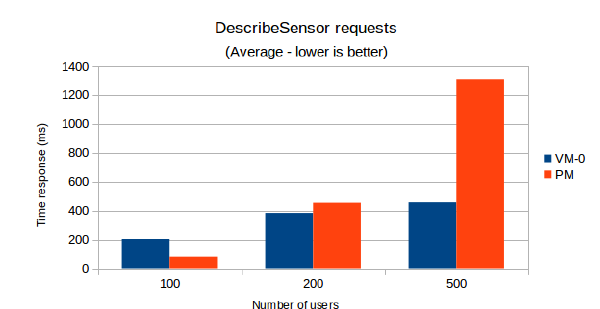
Figure 10. Average response time in milliseconds for the DescribeSensor request with 100, 200 and 500 concurrent users both for the VM-0 and PM.